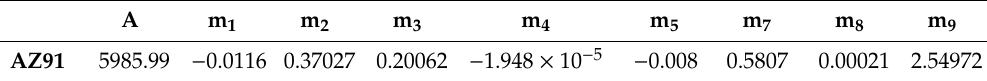
Figure 4. Shape and dimensions of rhombic-trapezoid dies used for AZ91 magnesium alloy forging. Main process parameters of the forging operation were selected based on our previous research and source literature [24–33]. The upper anvil speed was adopted at V = 8 mm/s, while the lower anvil was stationary. The description and flow diagram of the elongation operation are shown in Figures 5 and 6. Figure 5 contains a diagram of elongation an AZ91 alloy bar in flat dies. The first stage, three single-sided forging passes with a forging reduction of 40% and a relative feed of 0.8 were made, as per the forging direction indicated in the figure. Next, the forging was rotated, as shown in Figure 5 and the dies returned to their starting position. This was followed by three consecutive forging passes (4, 5 and 6), with the same forging reduction and relative feed. Figure 6 shows the diagram of an AZ91 alloy bar elongation operation in trapezoid-rhombic dies. The first stage of the process involved two first forging passes, with single-sided forging, relative forging reductions of 25% and relative feed of 0.8. Next, the forging was rotated, as shown in Figure 6, the dies returned to the start of the forging, in the place of the Cartesian coordinate system, and two subsequent forging passes (3 and 4) were conducted, with a forging reduction of 40% and the same relative feed.